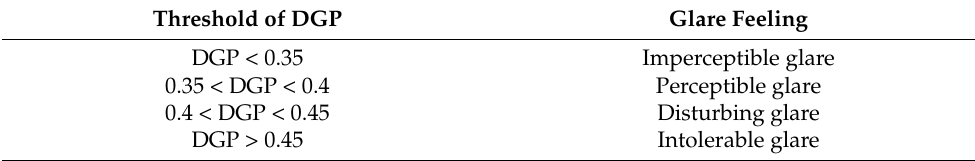
Table 3. Threshold of DGP